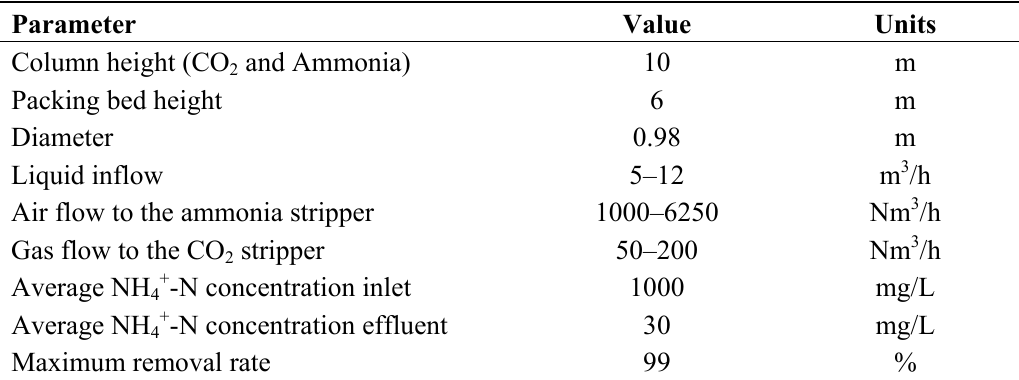
Table 2. Dimensions and operational conditions of the stripping